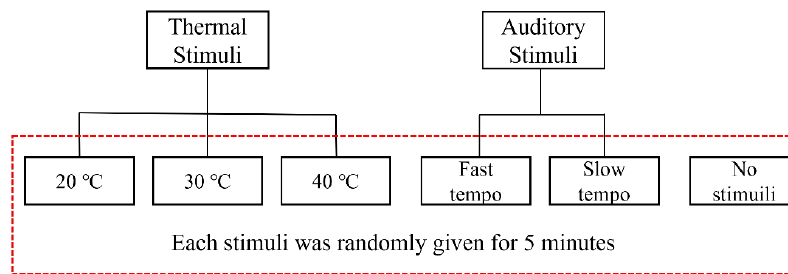
Figure 1. Process of the experiment.